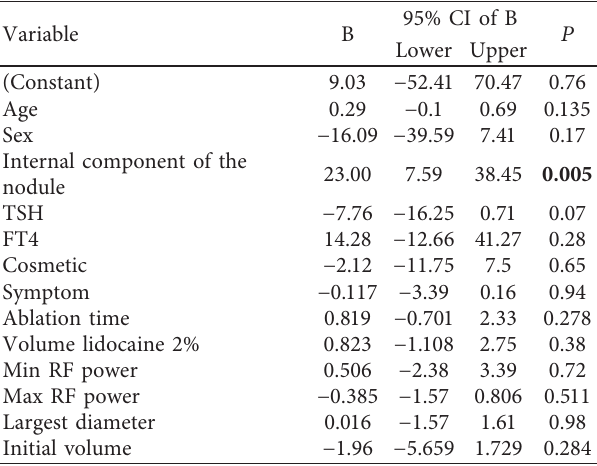
Table 4: Factors independently predictive of volume reduction via multiple linear regression